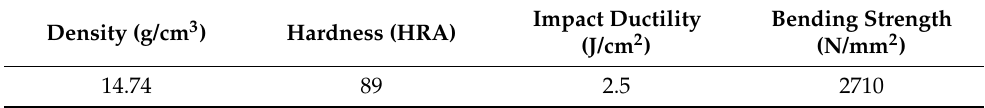
Table 1. The physical and mechanical properties of cemented carbide.